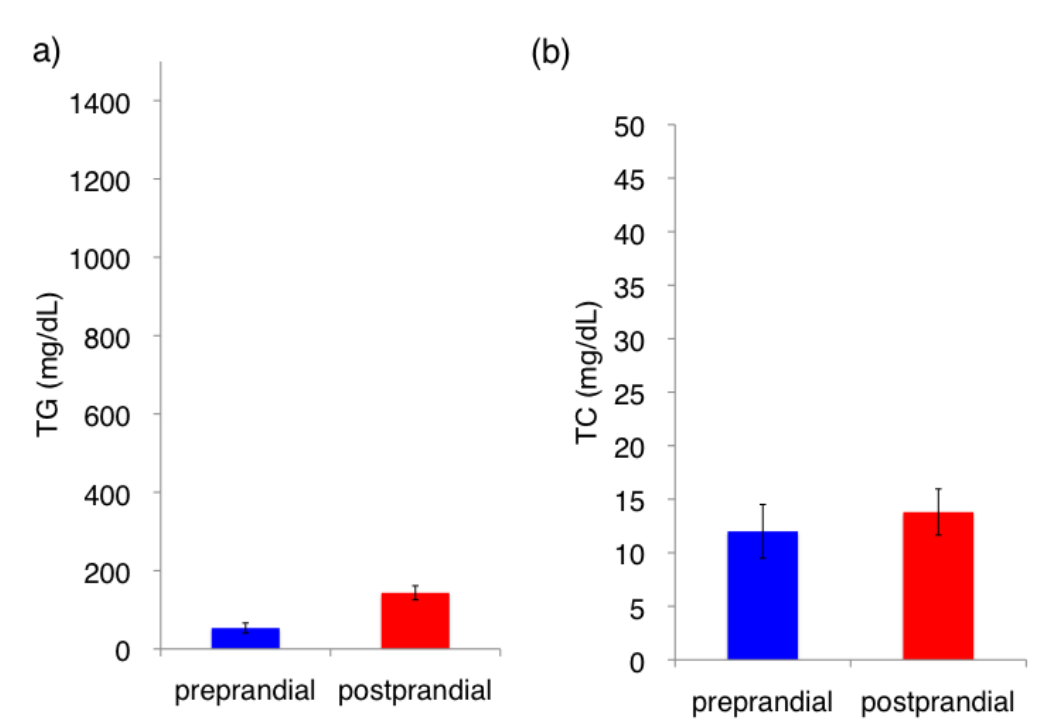
Figure 2. Plasma lipid concentrations in the normal JW rabbit before (preprandial; blue columns) and 18 h after feeding (postprandial; red columns). ( a ) Triglyceride (TG) ( b ) Total cholesterol (TC).